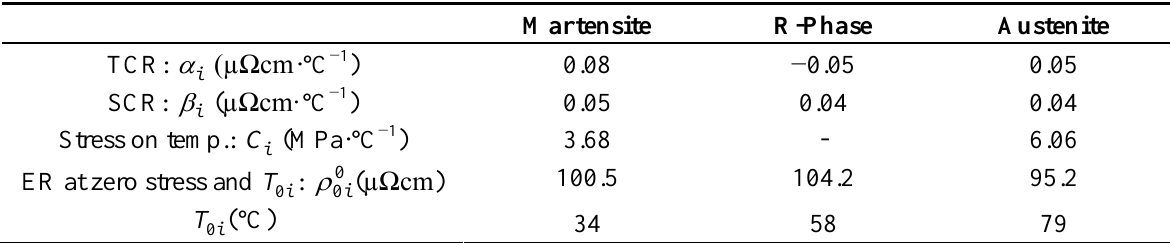
Table 1. Experimental material parameters of SMA wires.